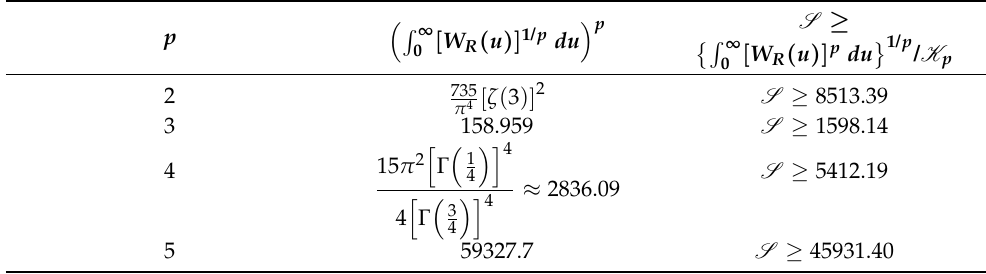
cm − 3 . The required values of ·